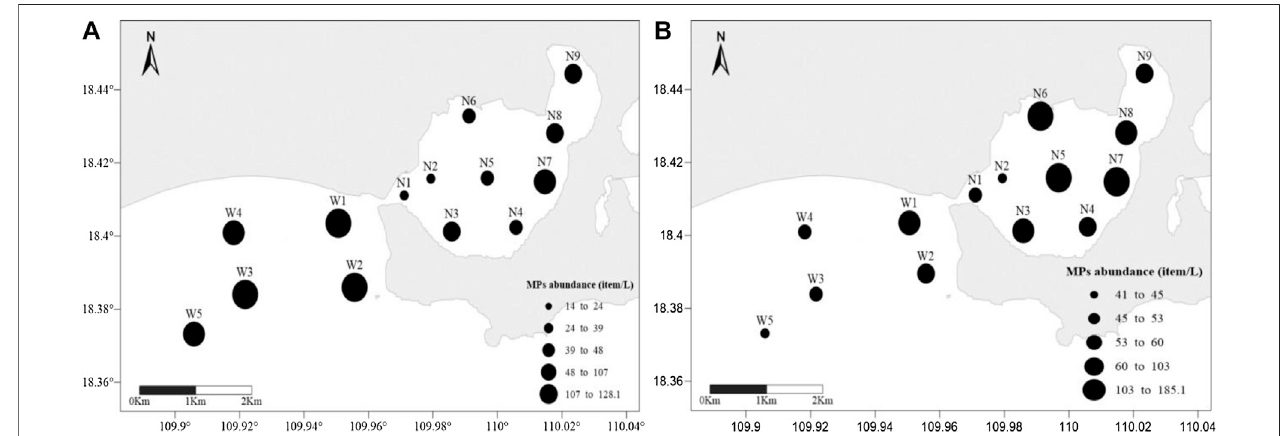
FIGURE 2 | Microplastic abundance in surface water during the rainy season (A) and dry season (B) (W1-W5 located outside Xincun Bay, N1-N9 located inside Xincun Bay).